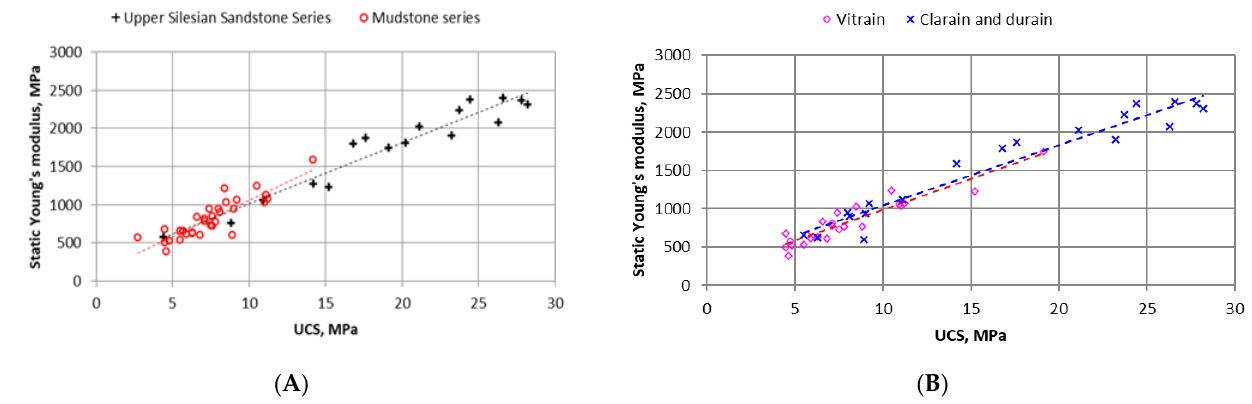
Figure 6. E st = f (UCS) dependence for hard coals: ( A ) from the Mudstone Series and the Upper Silesian Sandstone Series; ( B ) lithotypes vitrain, clarain, and durain.